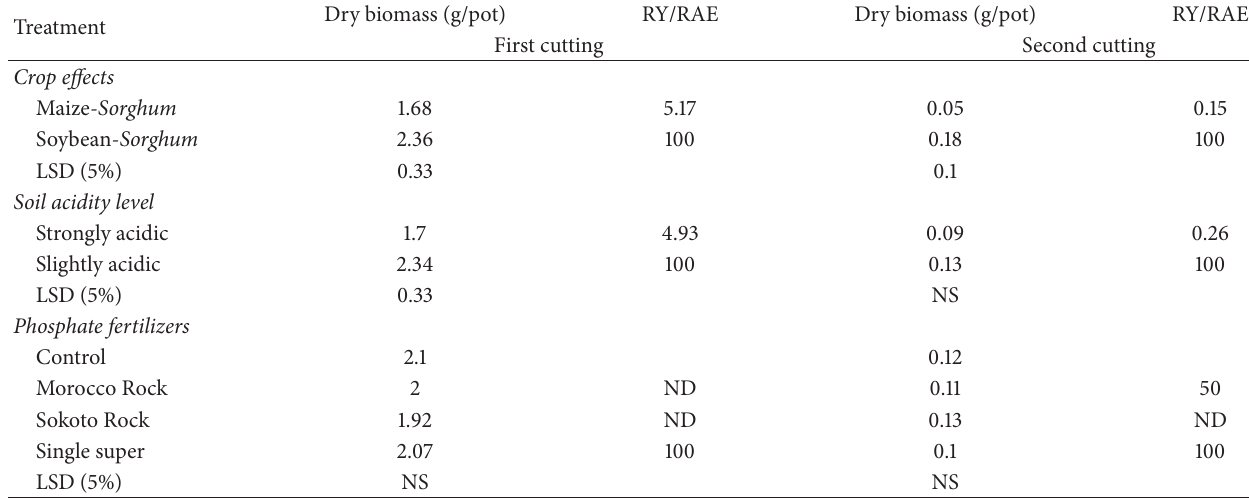
Table 6: Influence of the soils, P-source, or crop effects on biomass yield (g/pot) of Sorghum plants in the second cropping.